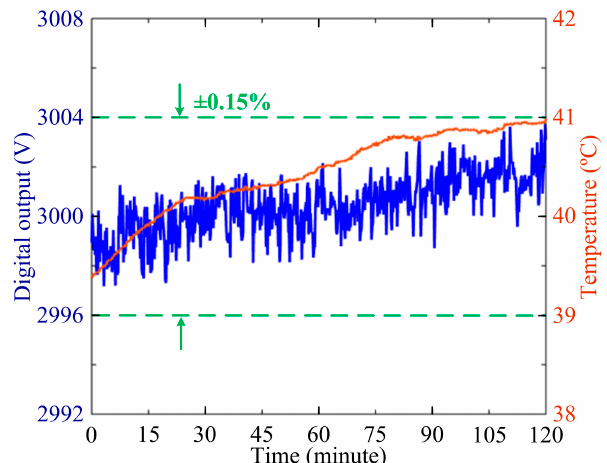
Figure 12. The long-term measured stability of OVS at 3000 V AC over two hours when the temperature is maintained at +40 °C by the temperature-controlled chamber.